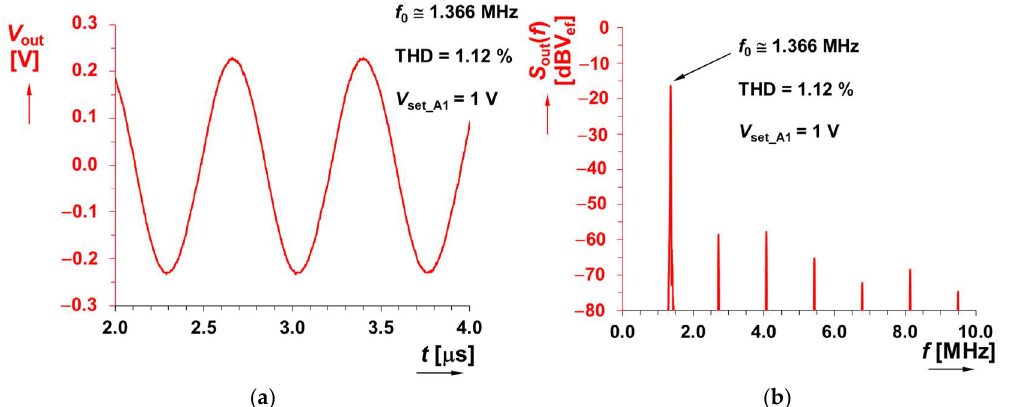
Figure 9. Analysis of the oscillator from Figure 8: ( a ) oscillation frequency versus driving voltage V set_A1 and ( b ) output level and THD versus oscillation frequency.